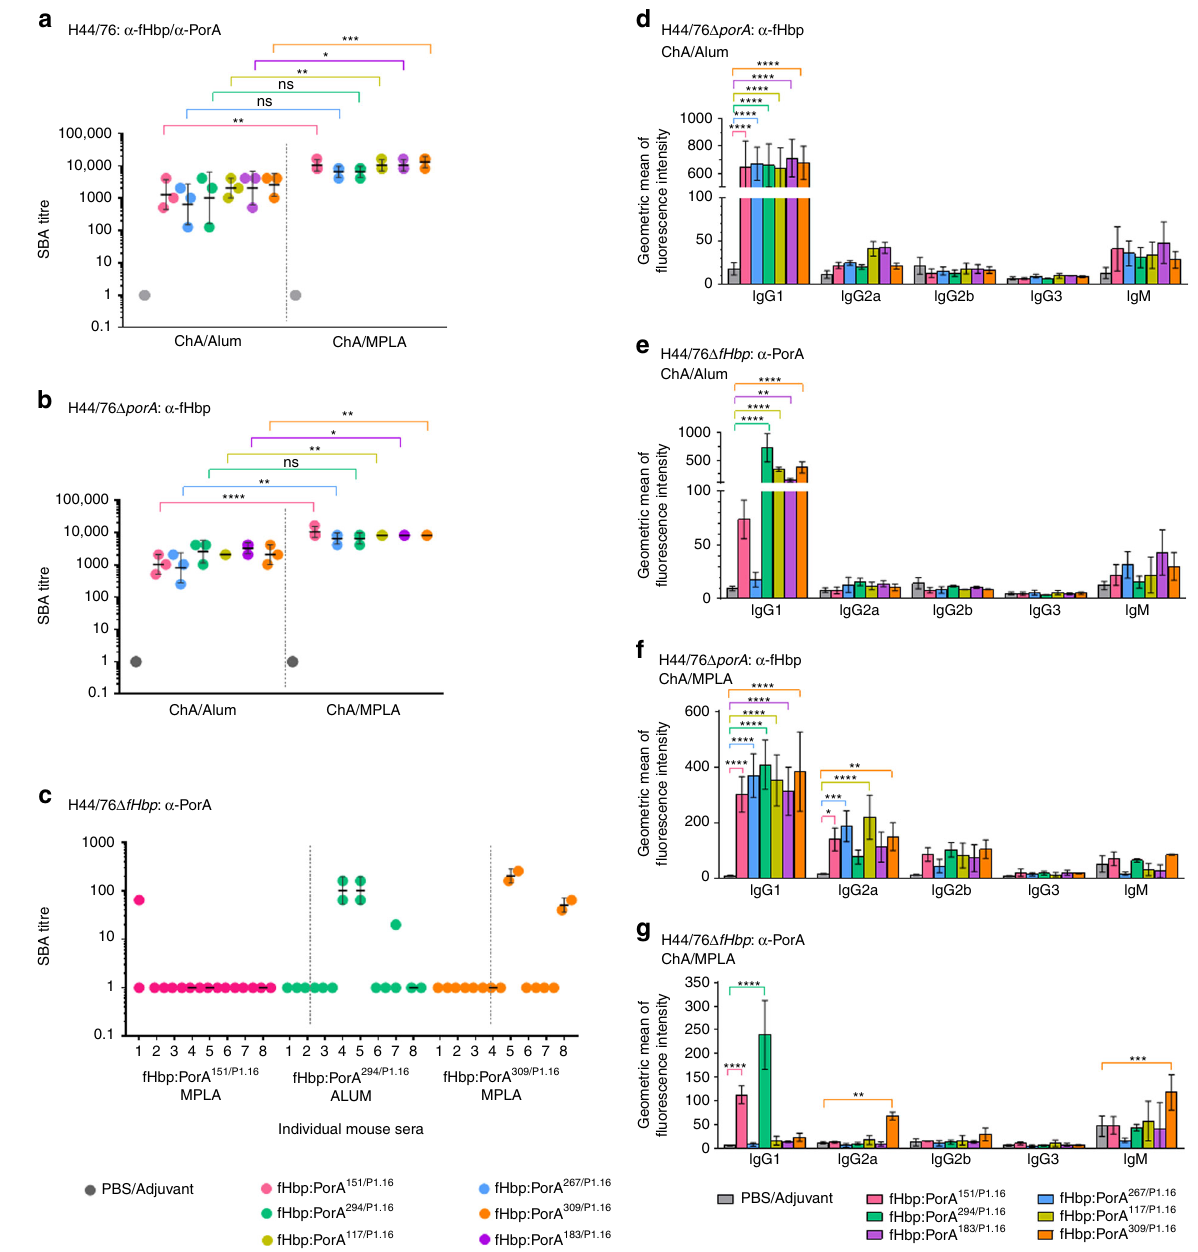
Fig. 3 Immunogenicity of ChAs. Titres from SBAs performed with N. meningitidis strains H44/76 ( a , n = 3), H44/76 Δ porA ( b , n = 3), and H44/76 Δ fHbp ( c , n = 2) and ChA/adjuvant antisera. SBAs with H44/76 and H44/76 Δ porA were conducted using pooled ChA/adjuvant antisera, and SBAs with H44/ 76 Δ fHbp were conducted with ChA/adjuvant antisera from individual mice. Geometric mean and s.d. of independent assays ( n > 2) are indicated. Flow cytometry was used to detect binding of mouse isotypes IgG1, IgG2a, IgG2b, IgG3 and IgM in ChA antisera to N. meningitidis strains H44/76 Δ porA ( d , f ) and H44/76 Δ fHbp ( e , g ). Mouse isotypes binding to N. meningitidis were detected with isotype speci fi c secondary antibodies; s.d. of independent assays ( n = 3) is indicated. Two-way ANOVA and Dunnett ’ s method of multiple comparison were used to compare SBA titres from pooled antisera ( a , b ) and ChA antisera to PBS control sera ( d – g ) (* p ≤ 0.05, ** p ≤ 0.01, *** p ≤ 0.001, **** p ≤ 0.0001) ChAs retain the architecture of fHbp and the PorA loop . We Figure 2C), demonstrating that the fHbp scaffold is not per- determined the atomic structures of ChAs with VR2 P1.16 turbed by insertion of VR2 P1.16. In each structure VR2 P1.16 inserted into position 151, 294, or 309, all of which generated adopts a β -turn conformation that extends away from the fHbp PorA-dependent SBA titres. These structures were solved using scaffold (Fig. 4a). Importantly, these VR2 P1.16 conformations molecular replacement to resolutions of 2.9 Å for fHbp V1.4 : all mimic a VR2 P1.16 peptide in a complex with a bactericidal PorA 151/P1.16 , 3.7 Å for fHbp V1.1 :PorA 294/P1.16 and 2.6 Å for Fab fragment 39 (Fig. 4b, RMSDs of atomic positions range fHbp V1.4 :PorA 309/P1.16 . All ChA scaffolds align with good between 0.346 and 0.970), demonstrating that in ChAs VR2 agreement (route-mean-square deviations (RMSDs) range P1.16 adopts a conformation that can induce bactericidal anti- between 0.447 and 0.614) to fHbp V1.1 (Supplementary body responses 40 . NATURE COMMUNICATIONS | (2018) 9:1051 | DOI: 10.1038/s41467-018-03146-7 |